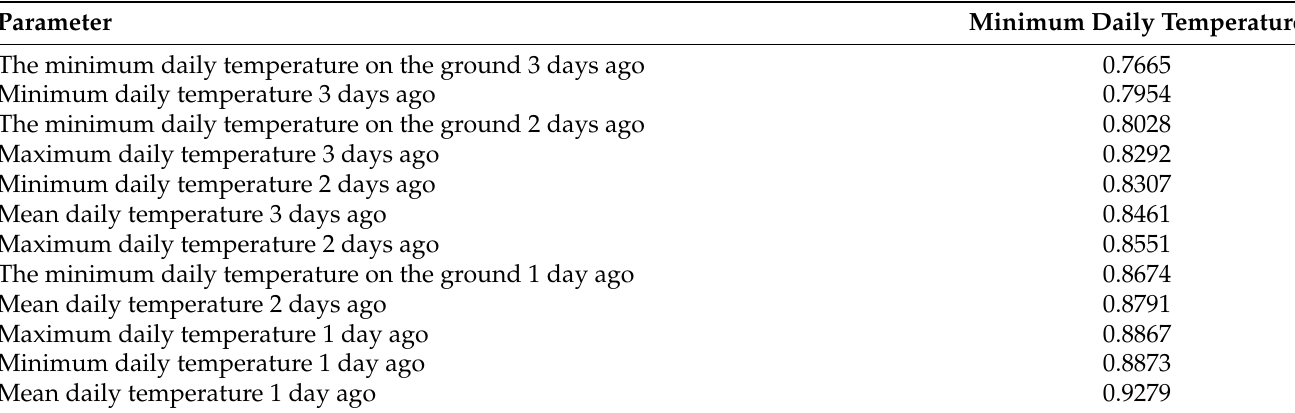
Table 16. The parameters with the strongest correlation to the predicted minimum